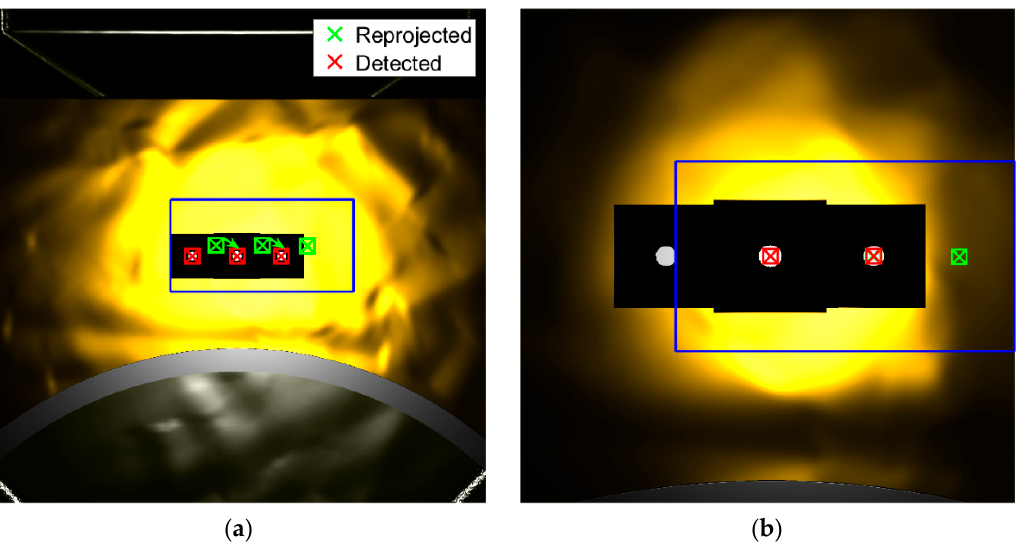
Figure 24. Consequences of the larger uncertainty on initial conditions, for test case E-I (in blue the RoI): ( a ) marker mismatch at simulation start caused by the larger uncertainties on the pose initial guess; ( b ) marker cut out of the RoI, at t = 322.10 s.